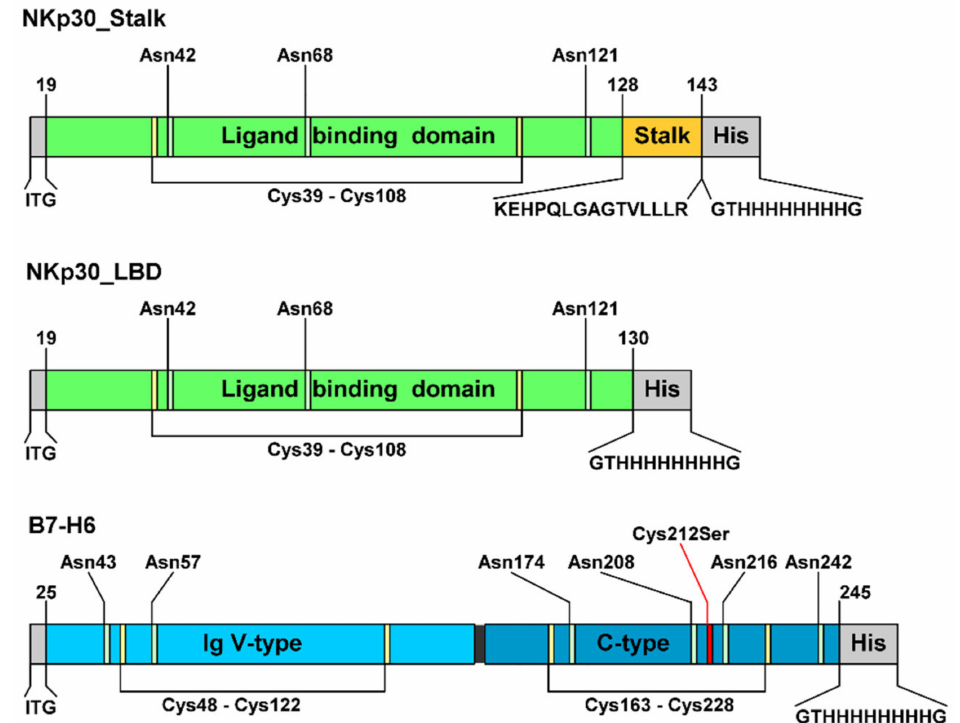
Figure 1. Recombinant NKp30 and B7-H6 expression constructs. All constructs contain three amino acids which remain after the secretion signal is cleaved at the N-terminus and a histidine tag sequence at the C-terminus. Glycosylated asparagine residues and cysteines forming disulfide bridges are indicated, as well as the mutation of the odd cysteine C212S in